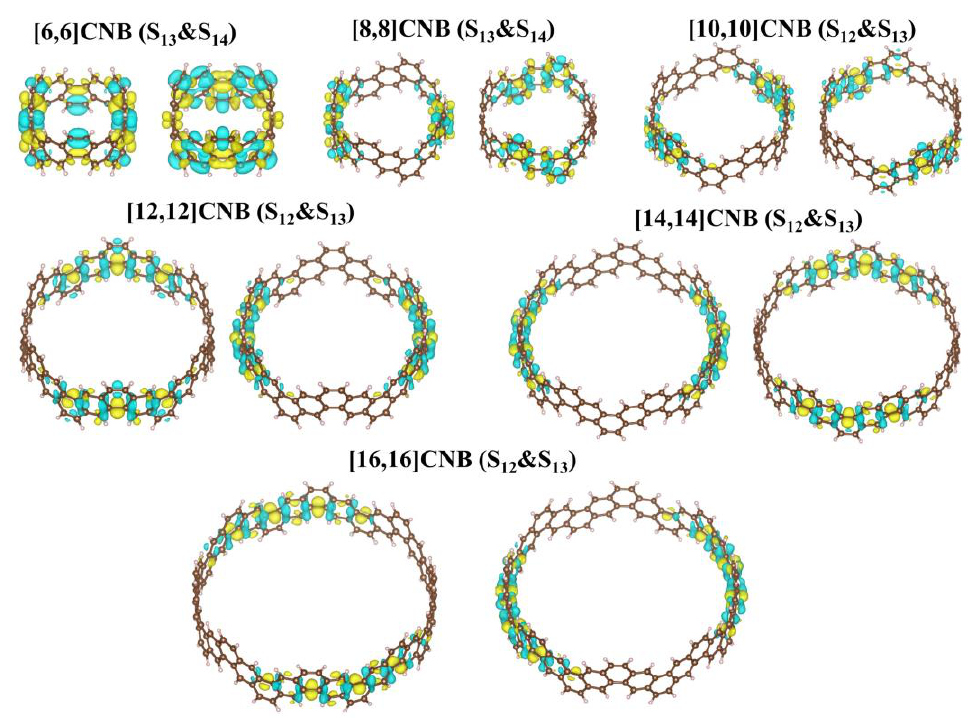
Figure 4. CDDs of the strongest absorption peaks of [2N,2N]CNB. Yellow and blue represent electrons and holes, respectively.